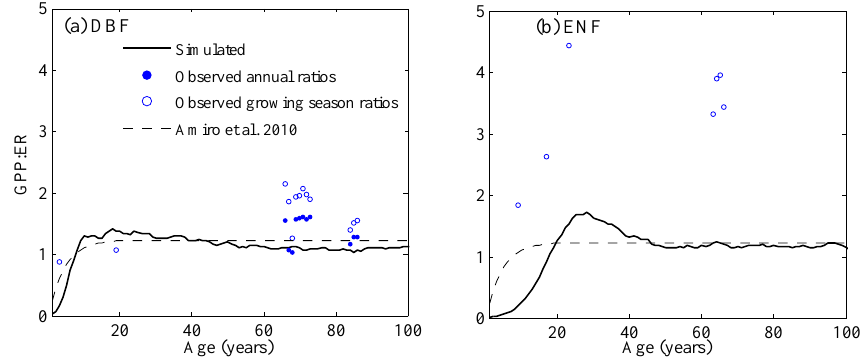
Figure 5. Simulated trajectories of the annual GPP / ER ratio with stand age for (a) deciduous broadleaf forests (DBF) and (b) evergreen needleleaf forests (ENF). The dashed line is a fitted curve derived by Amiro et al. (2010) using eddy covariance observations from for- est chronosequences in North America. Solid and hollow circles represent measured annual and growing season (May to October) ratios, respectively. The simulated curves were smoothed using a moving average filter with a span of